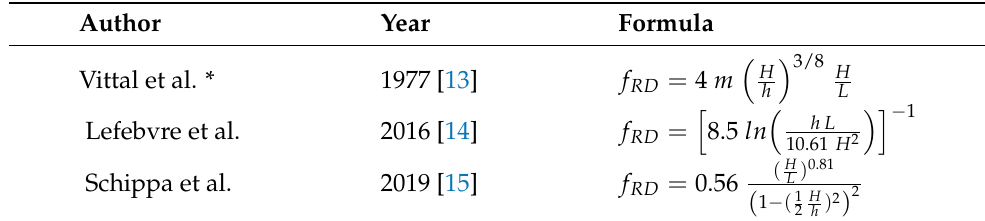
Table 3. Empirical approaches for f RD